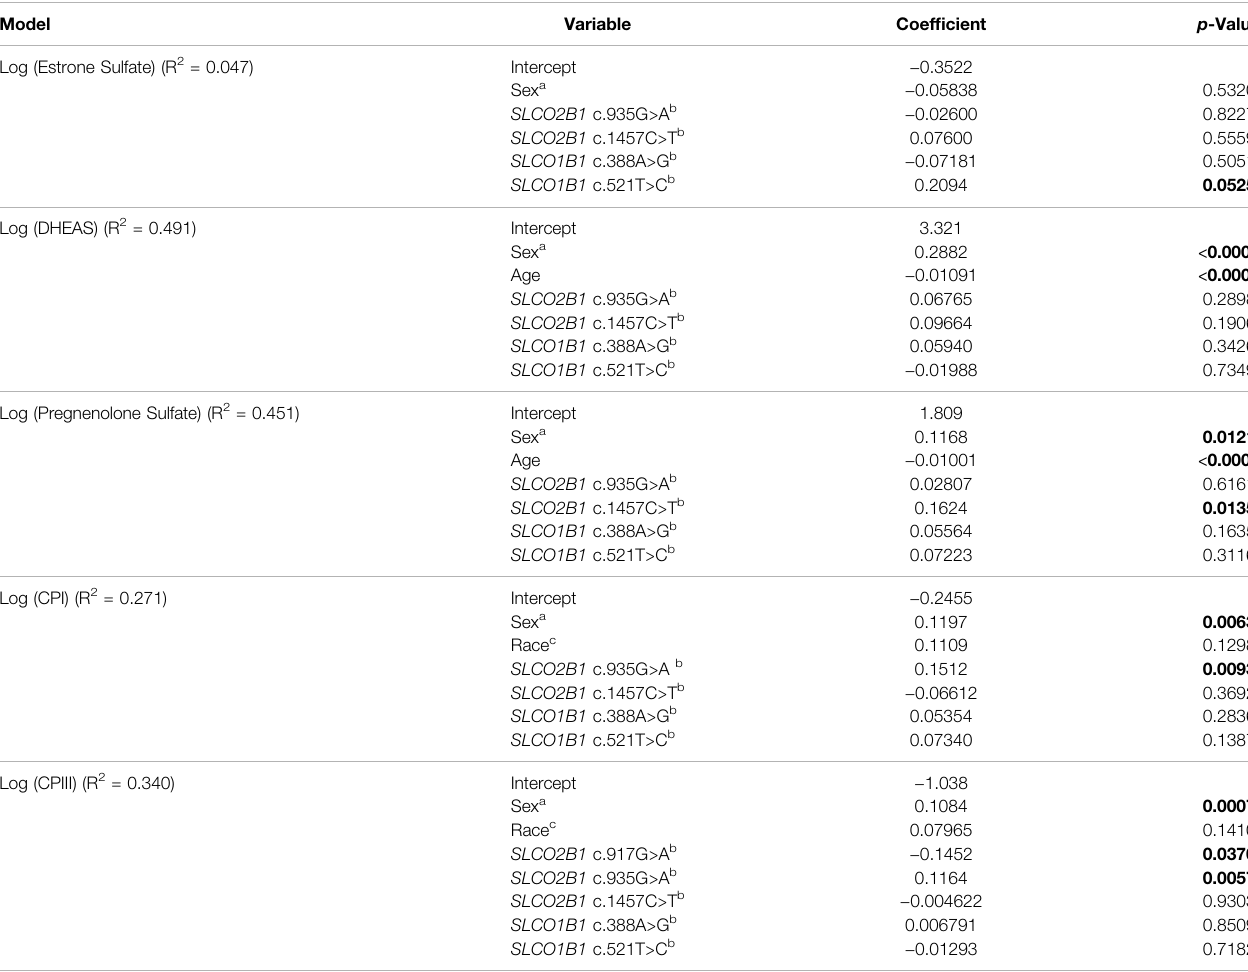
TABLE 5 | Multivariable linear regression models for circulating endogenous substrates of